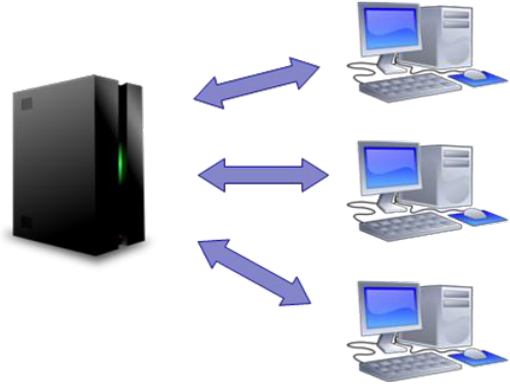
Figure 1. Building orthomosaic from a set of images